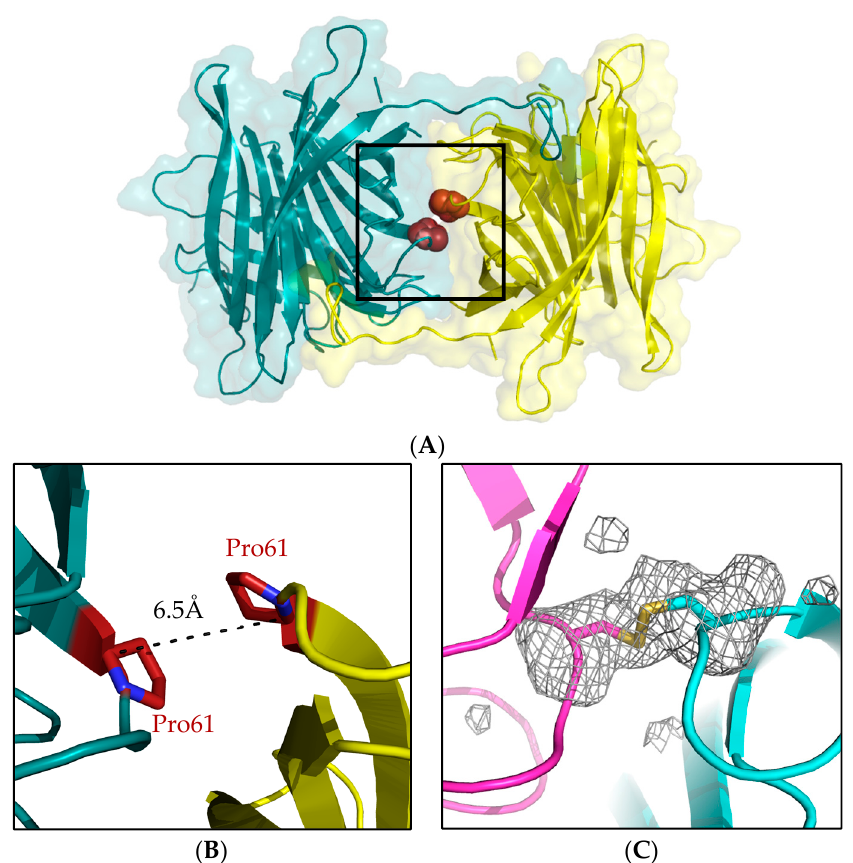
Figure 3. The P61C mutation site. ( A ) The interface between two non-canonical monomers where the mutation site was selected. ( B ) Enlargement of the region in the box showing the relative positions on Pro61 in the two monomers suitable for a mutation site based on C α distance. ( C ) The P61C mutation resulting in the formation of a disulfide bridge between the Cys61 residues, clearly indicated by the Fo-Fc unbiased omit map, removing residue Cys61. The map is calculated after several cycles of refinement and contoured at 2.5 σ cuto ff at the resolution range of 43.5–2.0